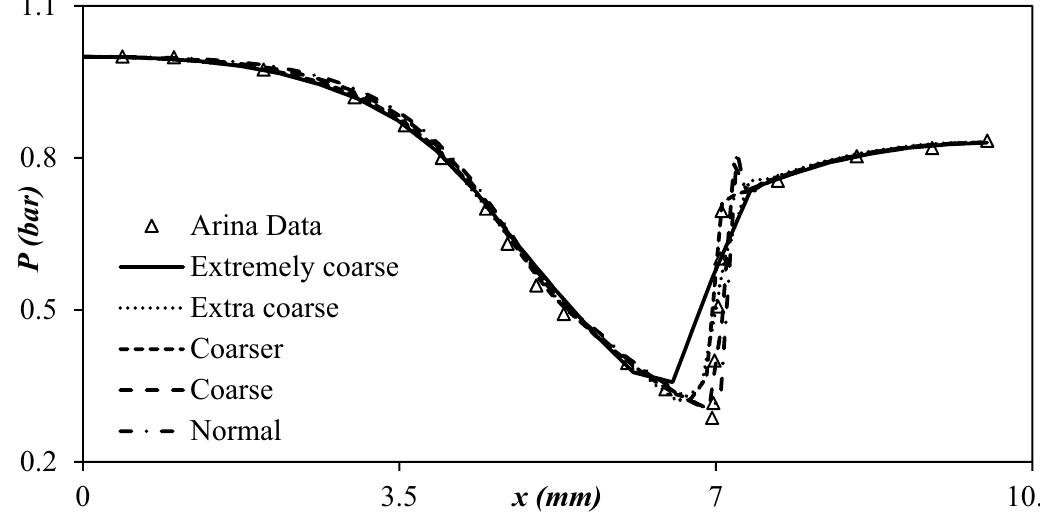
Figure 3. Comparison of simulation results with Arina’s data in different mesh